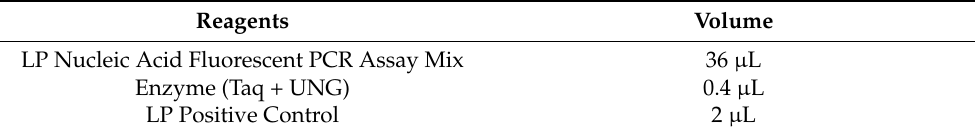
Table 2. Real-time PCR contents.